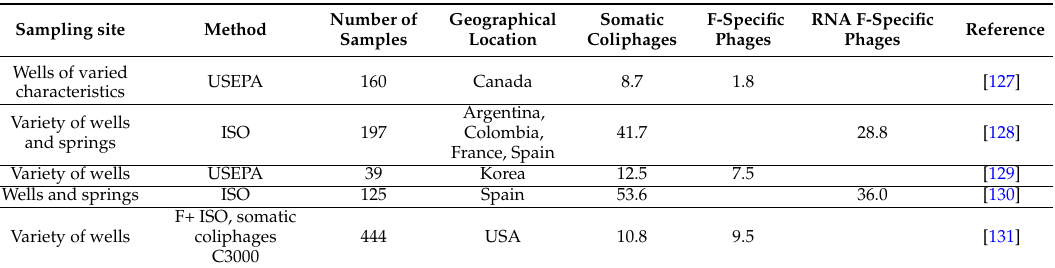
Table 2. Bacteriophages in groundwater (% of positive